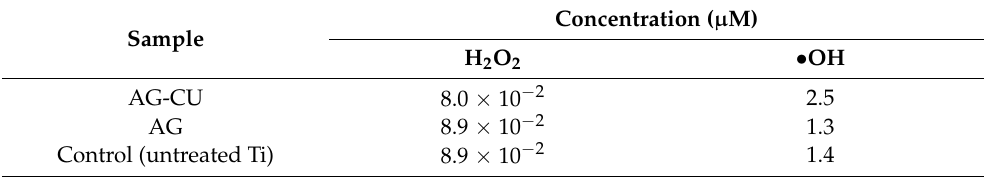
Table 3. Concentrations of hydrogen peroxide (H 2 O 2 ) and hydroxyl radical ( • OH) for